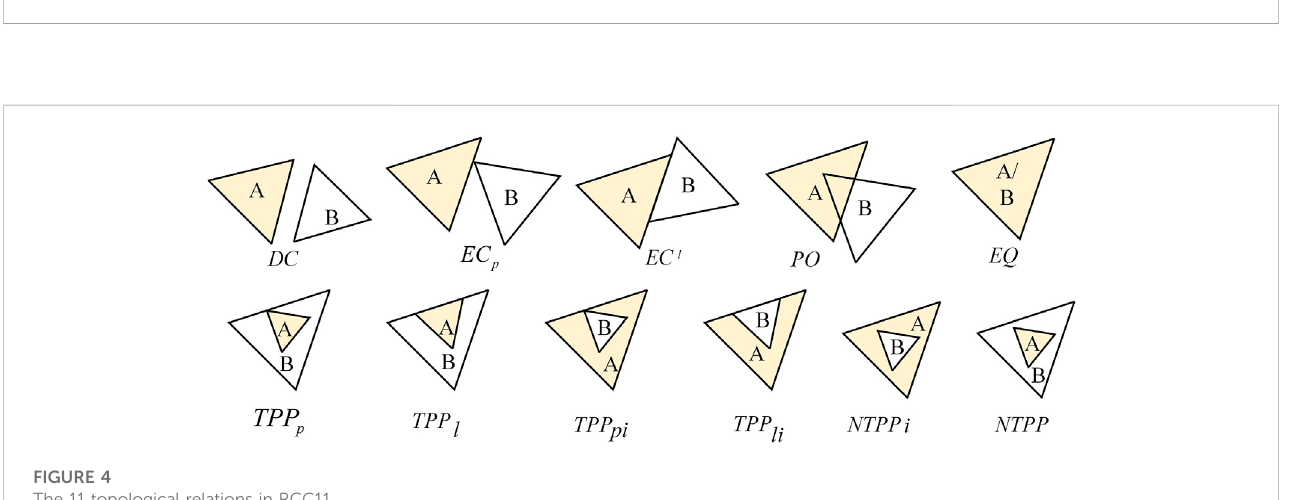
FIGURE 4 The 11 topological relations in